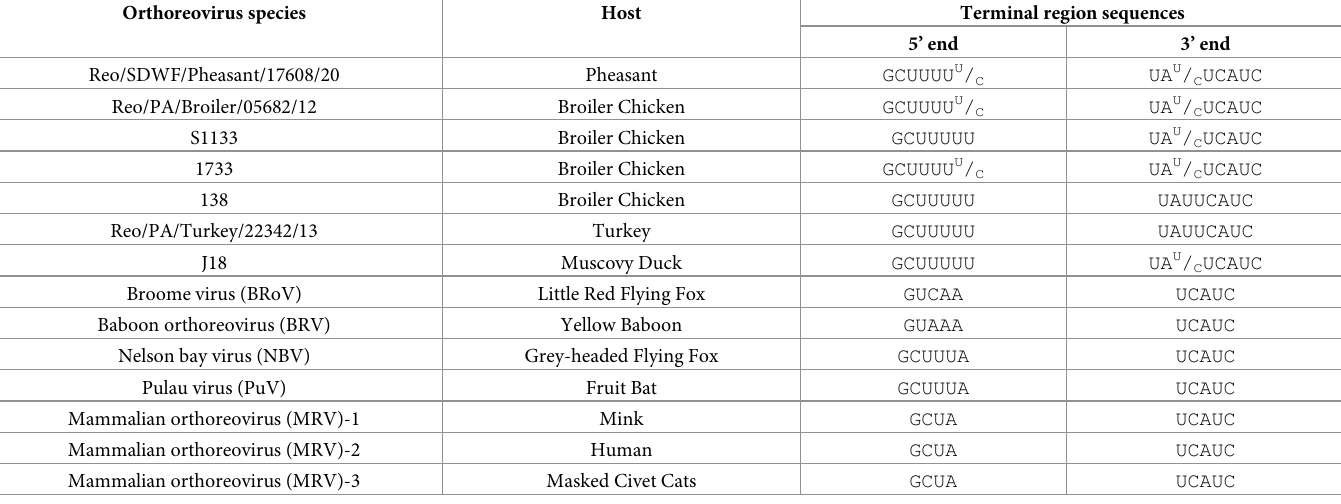
Table 3. Comparison of segment 5’ and 3’ non-coding regions of the pheasant ARV (Reo/SDWF/Pheasant/17608/20) with reference strains of Orthoreovirus genus members. Orthoreovirus